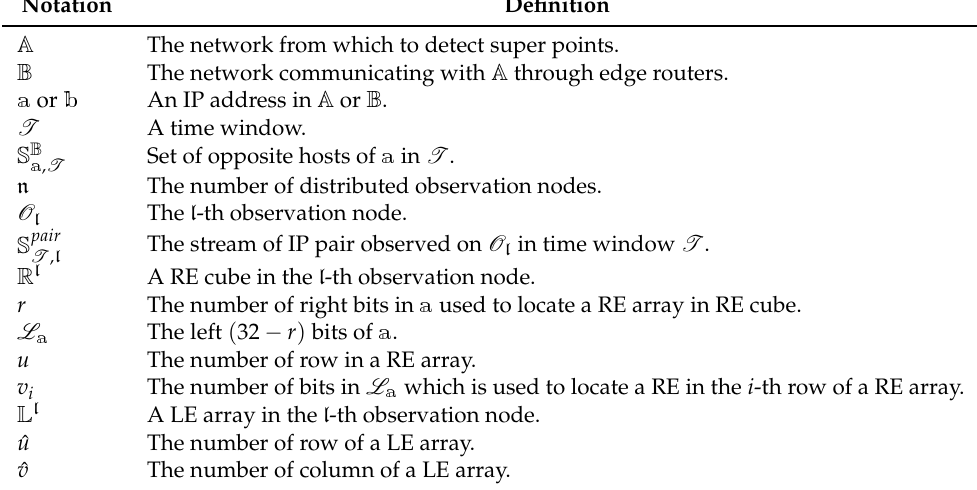
Table 1. Notations and symbols